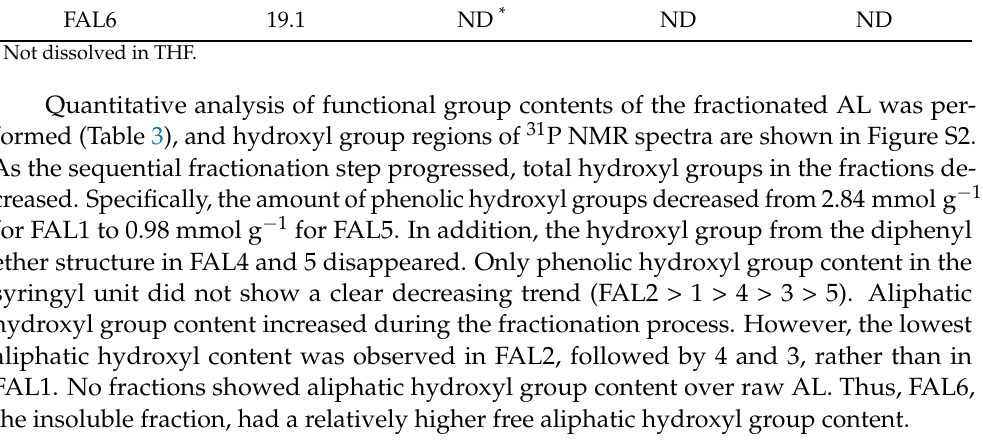
Table 3. Content in hydroxyl groups of fractionated AL quantified by 31 P NMR and methoxy group.